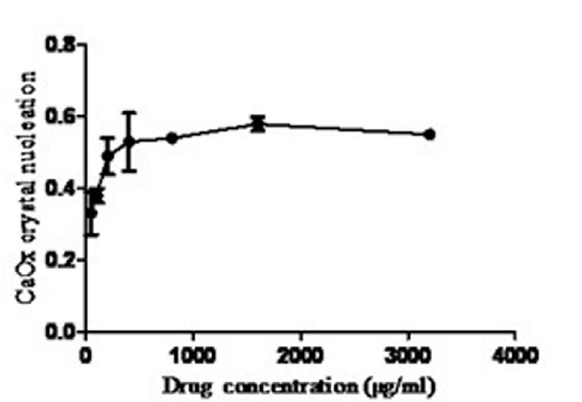
FIGURE 2 - Effect of EECR on CaOx crystal nucleation.